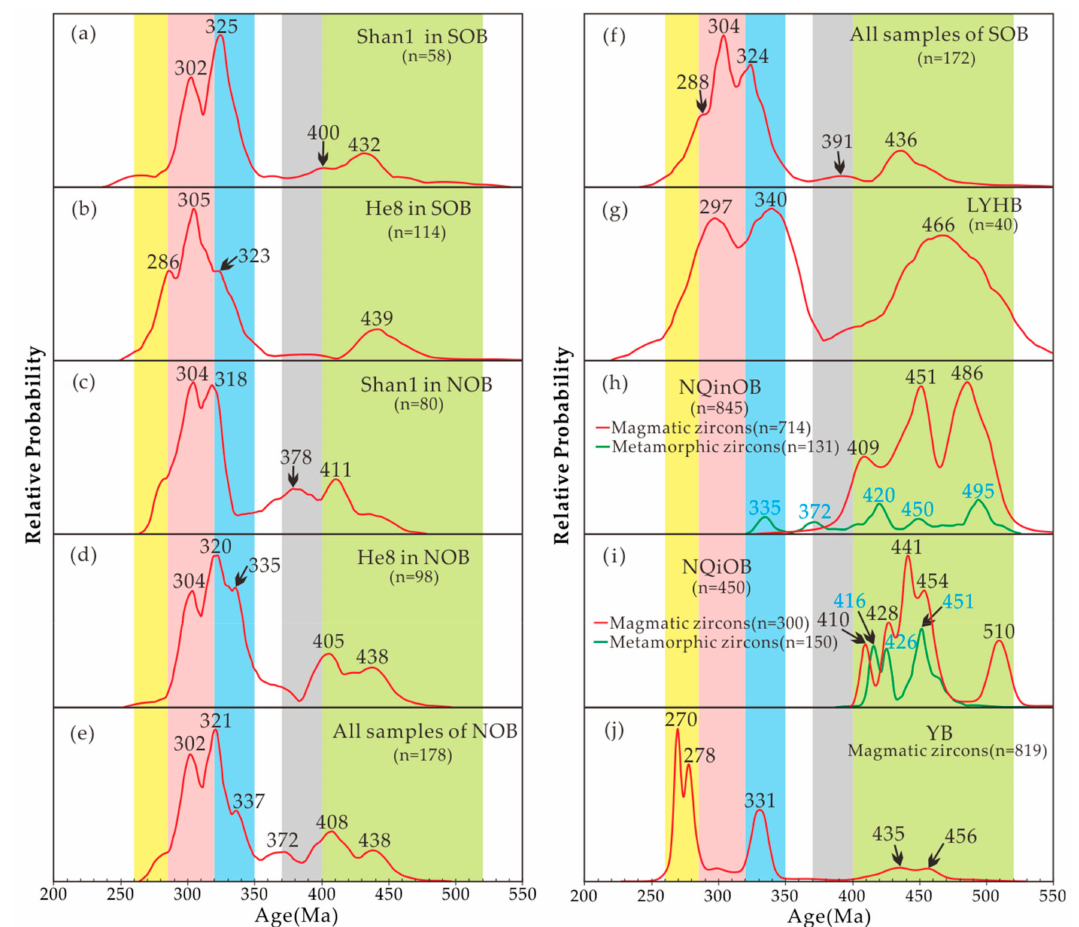
Figure 8. Contrasting relative probability plots of zircon U-Pb ages. Only those ages with a discordance of less than 10% are used. The yellow, pink, blue, gray and green bars show the age groups of 285–260 Ma, 320–285 Ma, 350–320 Ma, 400–370 Ma and 520–400 Ma, respectively. Data sources: (h) the